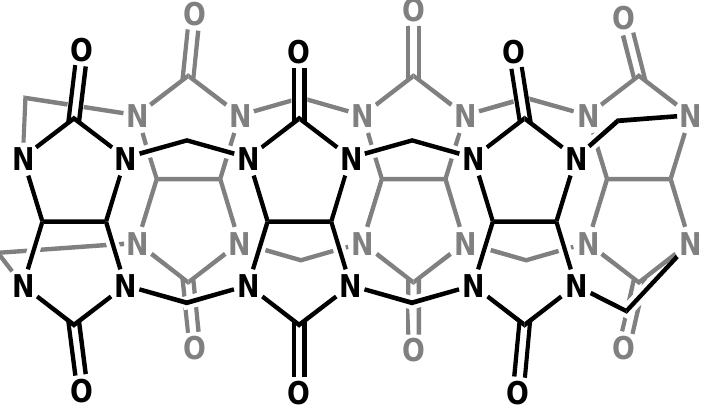
Figure 9 . The cyclic structure of cucurbituril,